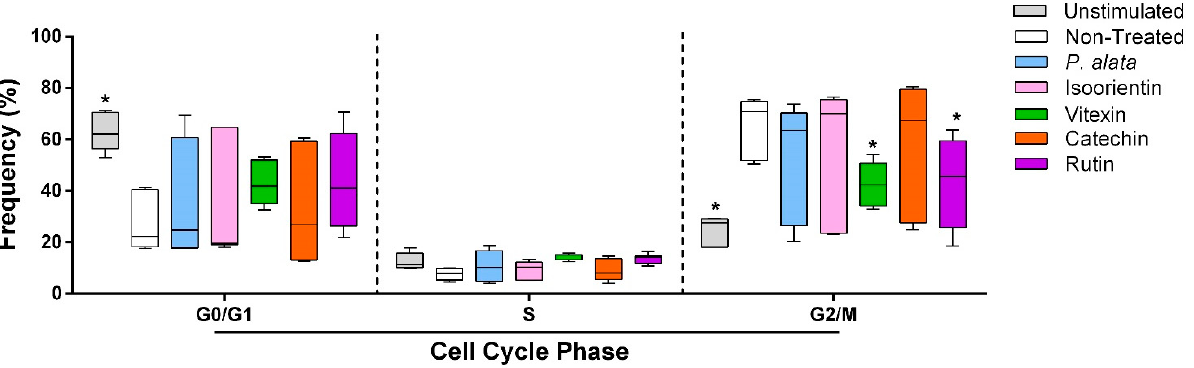
Figure 2. Effect of P. alata extract and polyphenols in the cell cycle of Concanavalin A (ConA)- stimulated T lymphocytes. The boxplots in panel represent the frequency of T cells in the G0/G1, S and G2/M phases of the cell cycle assay in the cell cultures stimulated with ConA and in the presence of IC 50 concentrations of P. alata (blue) and polyphenols: isoorientin (pink), vitexin (green), catechin (orange) and rutin (purple). Gray boxplots represent T cells not stimulated with ConA, and white boxplots are the non-treated cells stimulated with ConA: * p < 0.05; n = 6 with triplicate cell